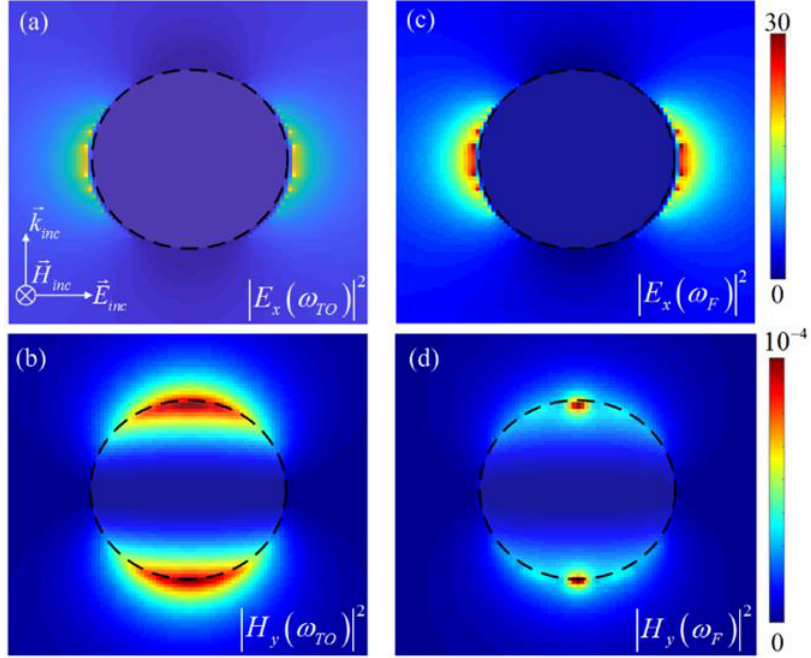
Figure 2. ( a , c ) The electric and ( b , d ) magnetic field intensities at ω TO = 24 and ω F = 28 THz for a Figure 2. ( a ), ( c ) The electric and ( b ), ( d ) magnetic field intensities at 4H-SiC nanoparticle, respectively, for n = 10 18 4H-SiC nanoparticle, respectively, for n = 18 10